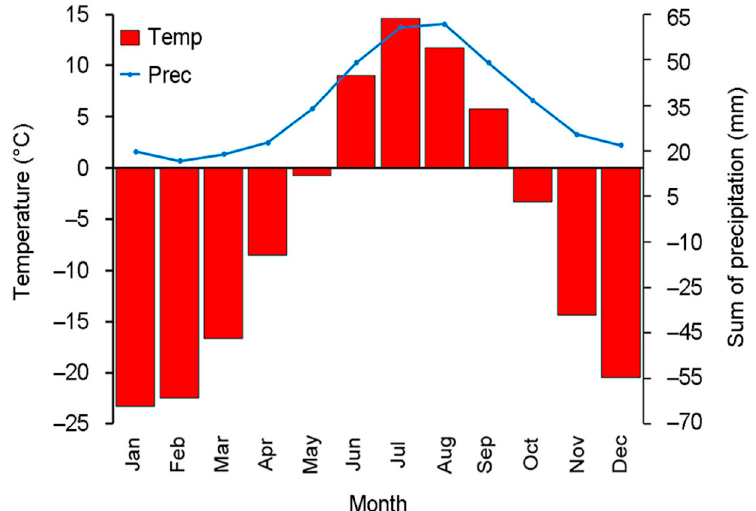
Figure 2. Climagram for Salekhard weather station (1892–2018). The blue line represents the long-term average sum of precipitation, red columns are the average monthly temperatures.